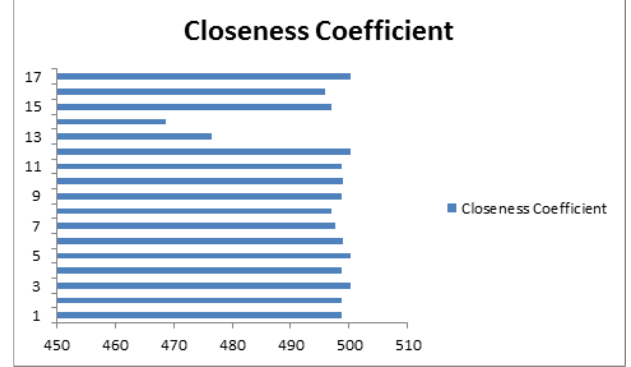
Figure 5. Closeness Coefficient